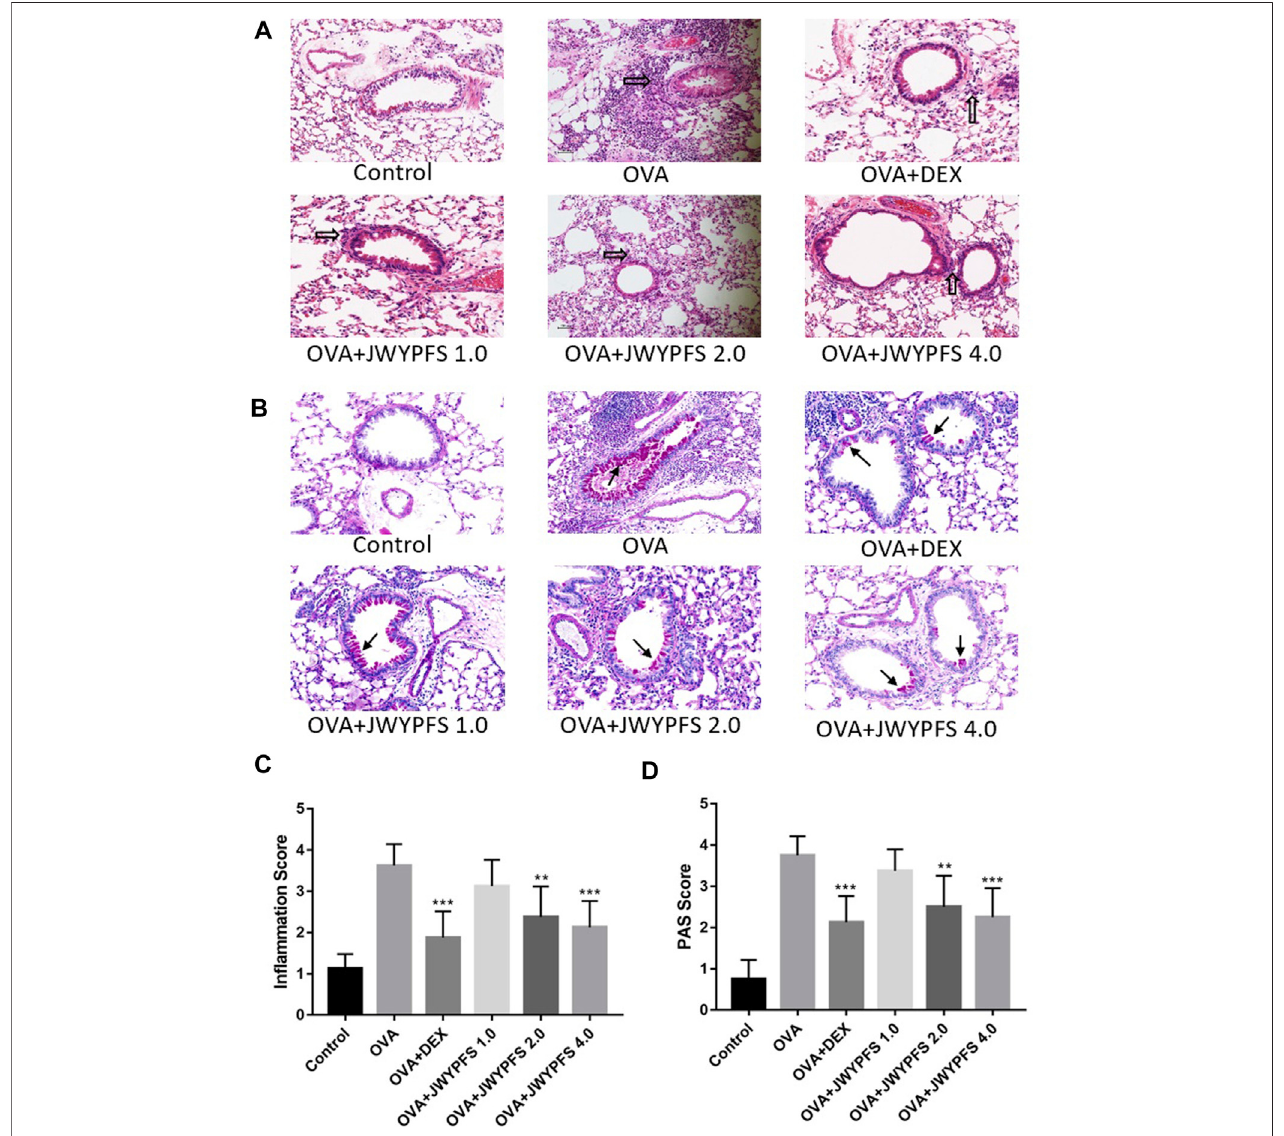
FIGURE 3 | The effect of JWYPFS on in fl ammatory cells and mucus production in lung tissue. (A) In fi ltration of in fl ammatory cells in the lung tissue as indicated by HE staining ( × 200). Black blank arrows indicate in fl ammatory cells; (B) Mucus secretion in lung tissue as indicated by PAS ( × 200). Black solid arrows indicate PAS- positive goblet cells; (C) Perivascular and peri-bronchial in fl ammation, scored as described in Materials and Methods. (D) A semi-quantitative analysis for the PAS- positive bronchi scoring. Data are shown as mean ± SD. * p < 0.05, ** p < 0.01, *** p < 0.001, compared with OVA group.